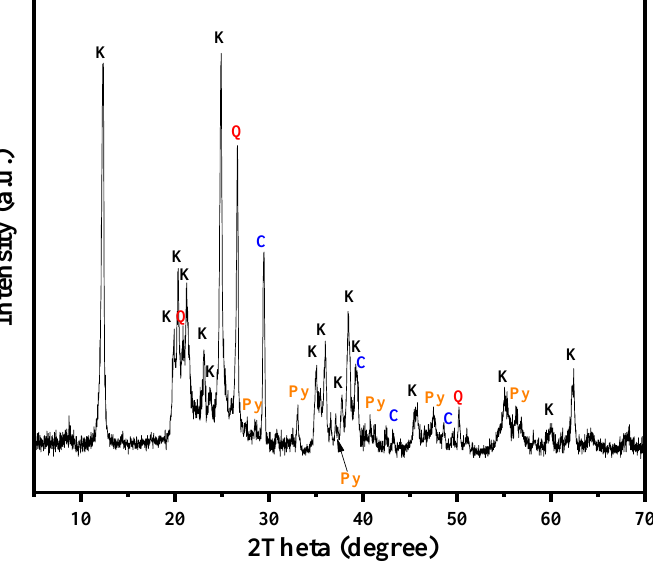
Figure 1. XRD pattern of the KAS (K — kaolinite, Q — quartz, C — calcite, Py — pyrite).